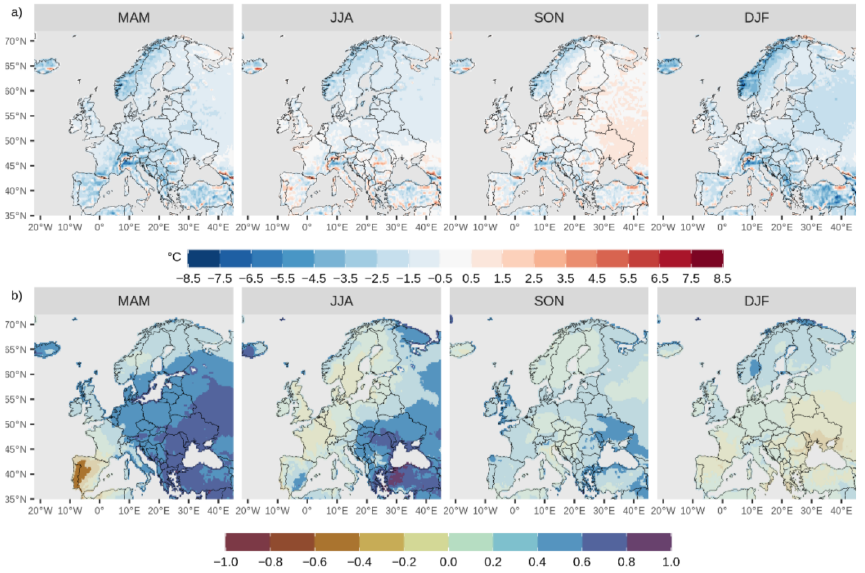
Figure 1. Spatial distribution of ( a ) ME and ( b ) CORR for unadjusted ECMWF SEAS5 ensemble forecasts of 2-m mean air temperature (one-month lead time) over Europe (land only) with re- spect to ERA5 reanalysis over 1993–2016. Significant correlation ( p -value < 0.05) is reported by unshaded